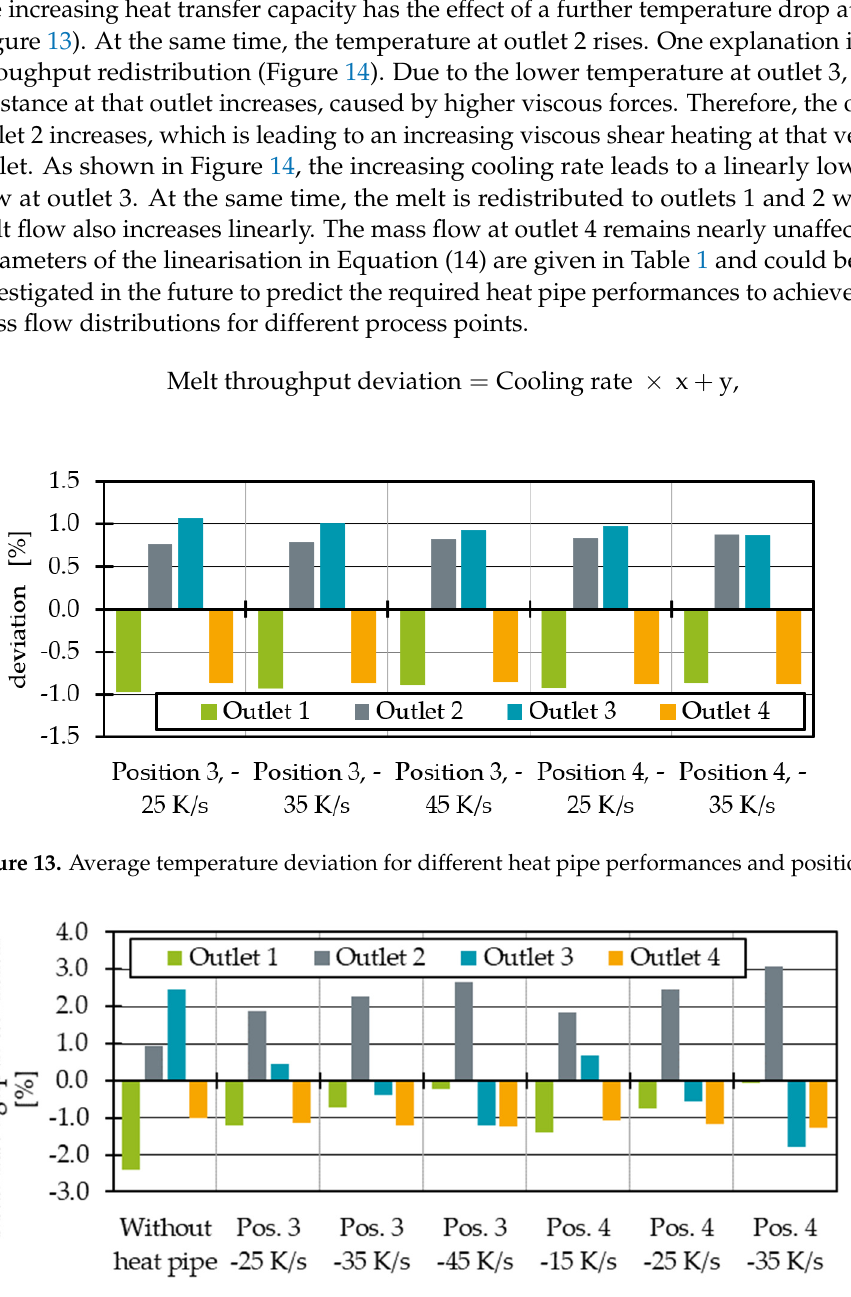
Figure 14. Melt throughput deviation for different heat pipe performances and positions. Table 1. Linearisation parameters to predict the melt throughput deviation in case of one heat pipe at position